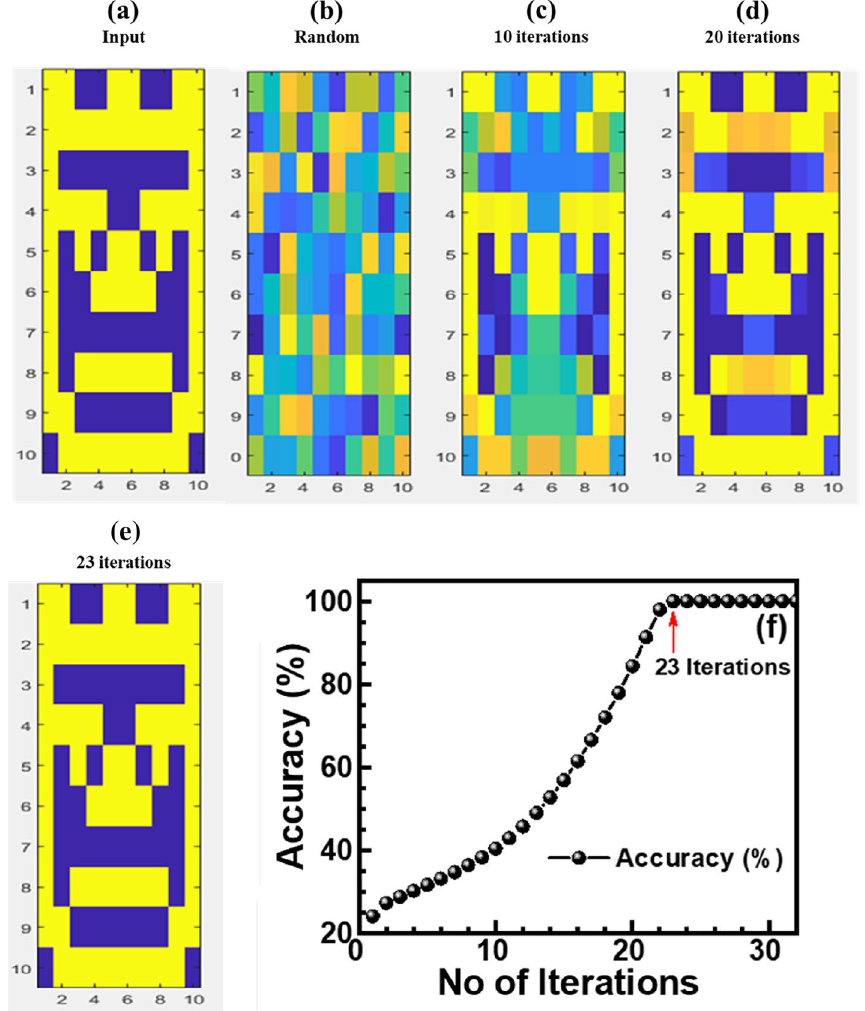
Figure 6. Training and recognition processes ( a ) input image, ( b ) random image, ( c ) image after 10 cycles, ( d ) image after 20 cycles, and ( e ) image after 23 cycles. ( f ) Change of recognition accuracy of ISHI-1 memristor with the number of